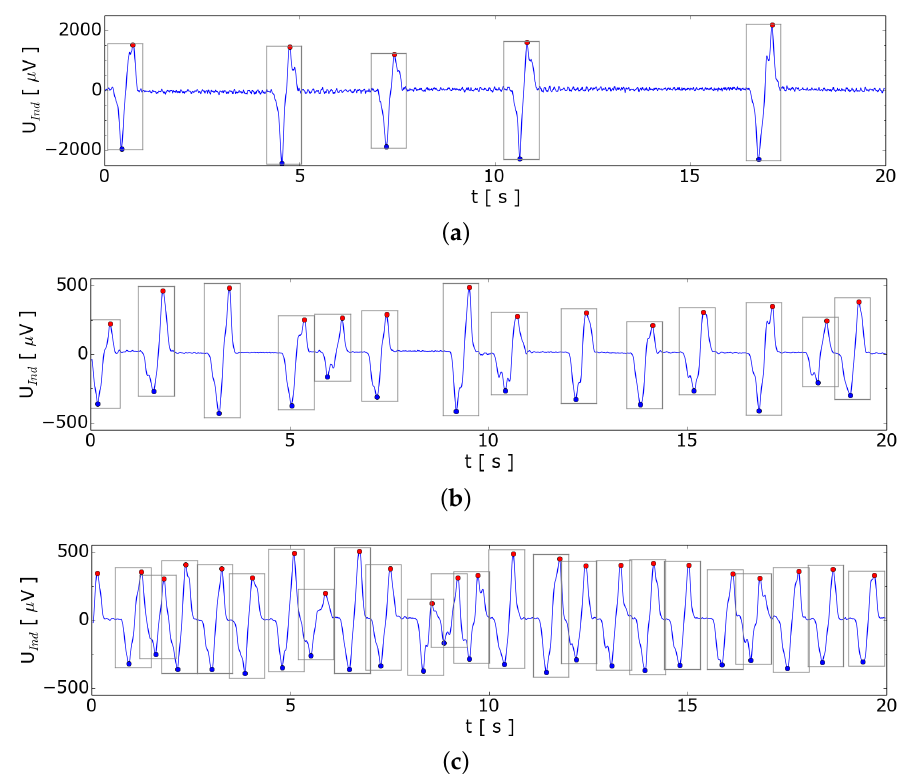
Figure 6. Demodulated signal from argon bubbles rising in the GaInSn column with automatic bubble detection. The bubbles are marked by rectangles; ( a ) Induced signal at 5.2 sccm argon with an average bubble diameter of 8.7 mm; ( b ) Induced signal at 5.6 sccm argon with an average bubble diameter of 6.3 mm; ( c ) Induced signal at 6.3 sccm argon with an average bubble diameter of 5.6